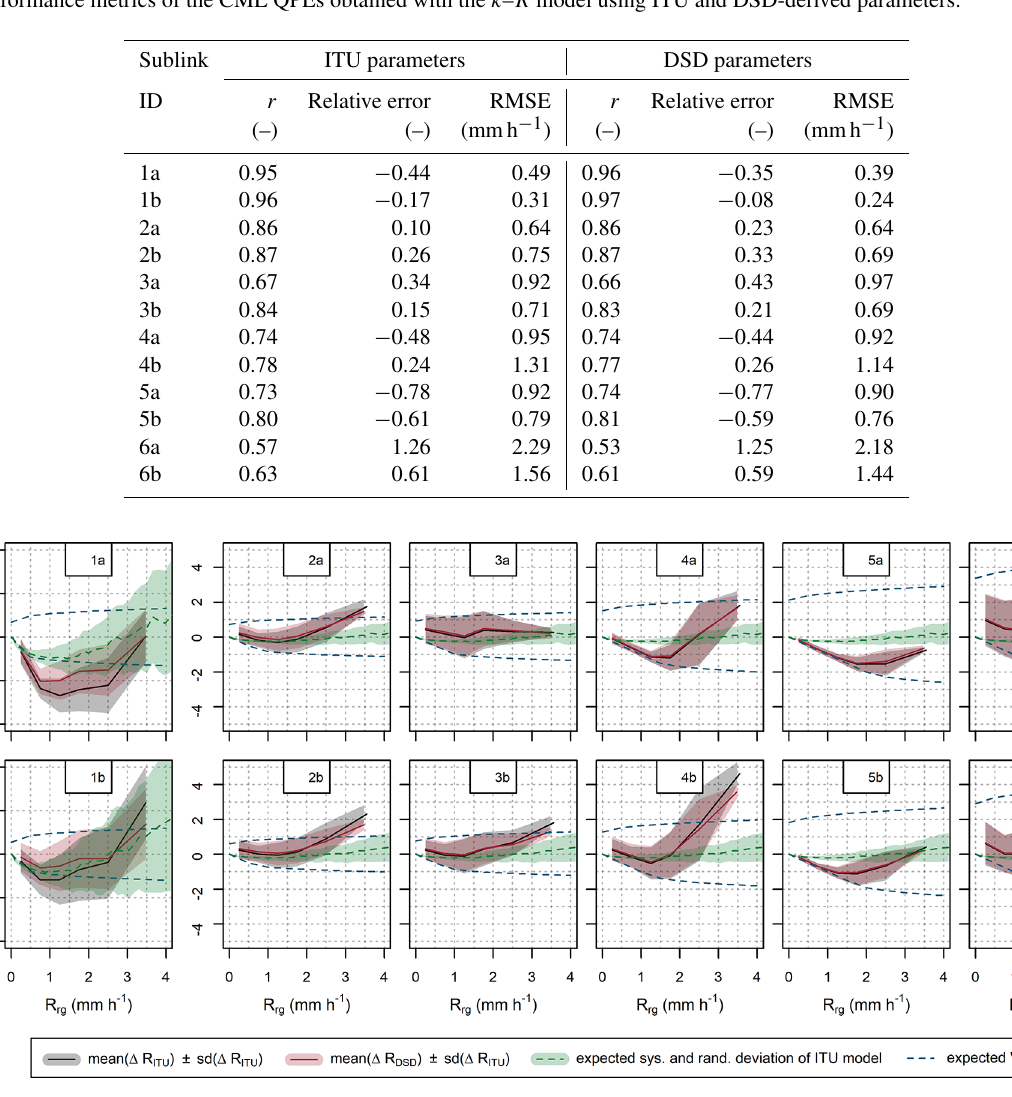
Table 3. Performance metrics of the CML QPEs obtained with the k – R model using ITU and DSD-derived parameters.